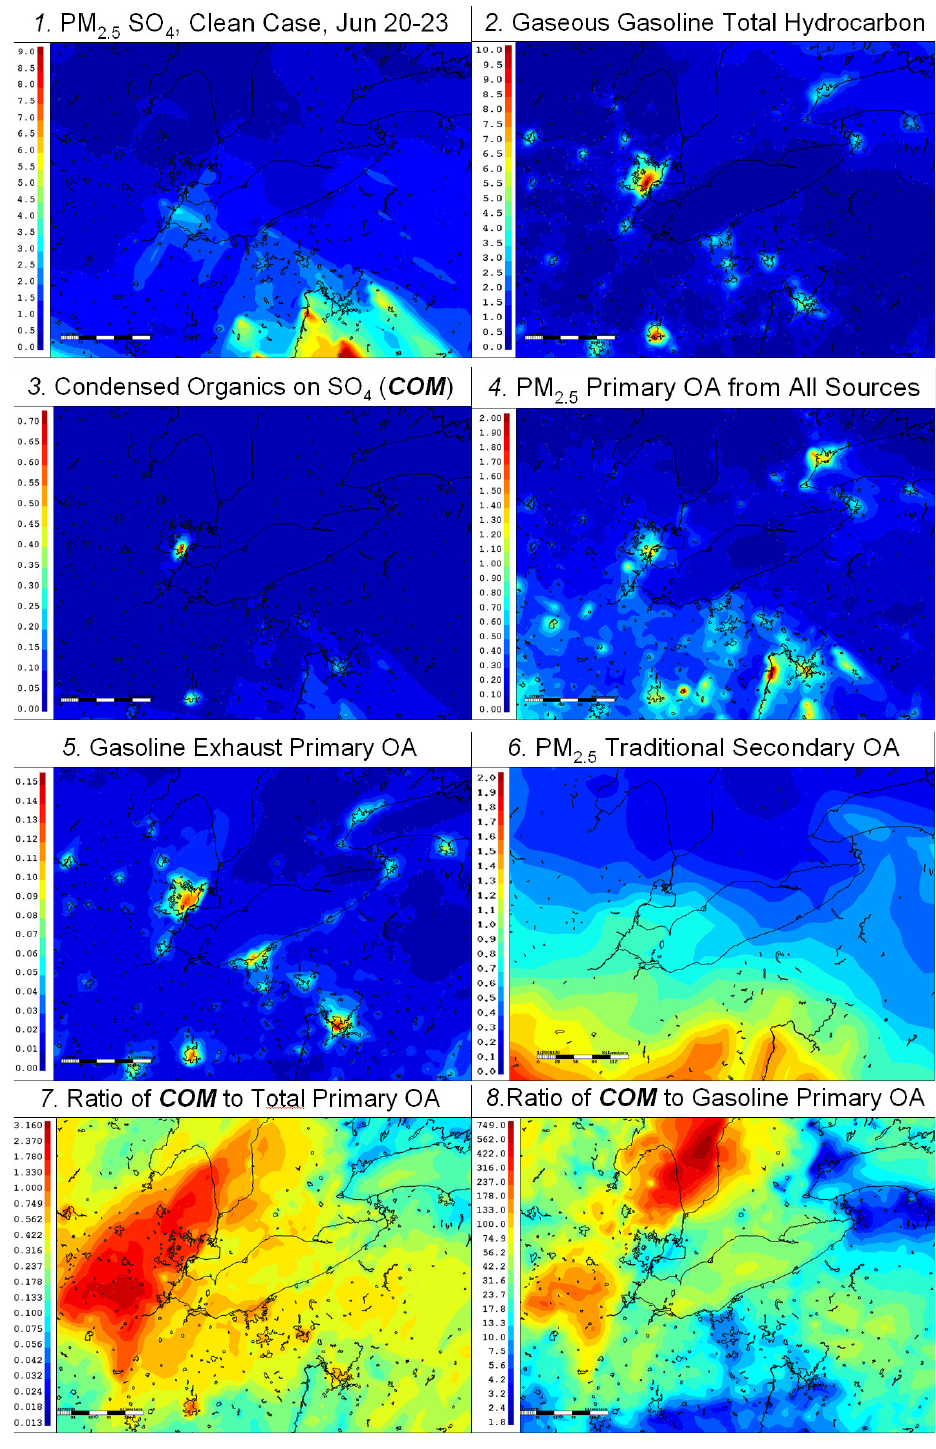
Figure 7. AURAMS model simulation of surface level ambient aerosols in µ g m -3 or ratios centering on Lake Erie. The simulation is for the polluted case from June 24 – 27: (1) average surface PM 2 . 5 SO 4 ; (2) gasoline engine exhaust THC; (3)COM on SO 4 from the gasoline engine exhaust THC; (4) PM 2 . 5 total primary OA mass from all sources; (5) COM from gasoline exhaust on PM 2 . 5 SO 4 ; (6) PM 2 . 5 secondary OA using traditional mechanisms; (7) ratio of COM to total primary OA from all sectors; (8) ratio of COM to primary OA from gasoline exhaust. The model grid resolution is 15 km.